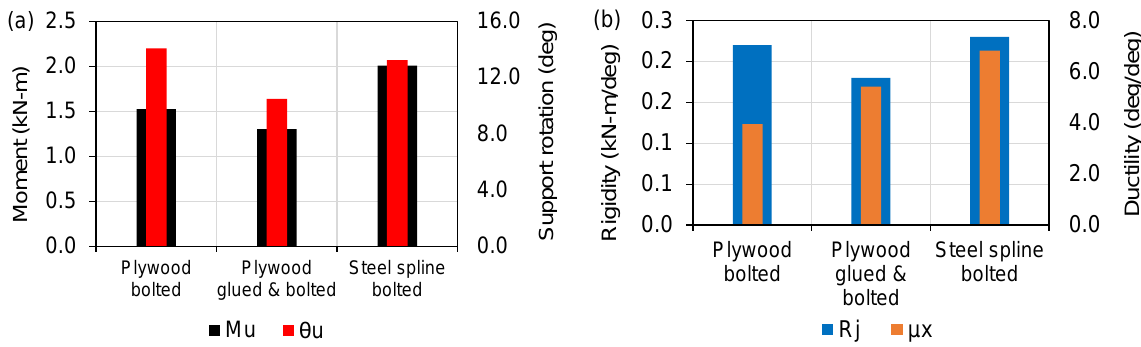
Figure 15. Comparison of ( a ) moment–rotation and ( b ) rigidity and ductility of the spline connections with different spline plates tested along the minor axis.